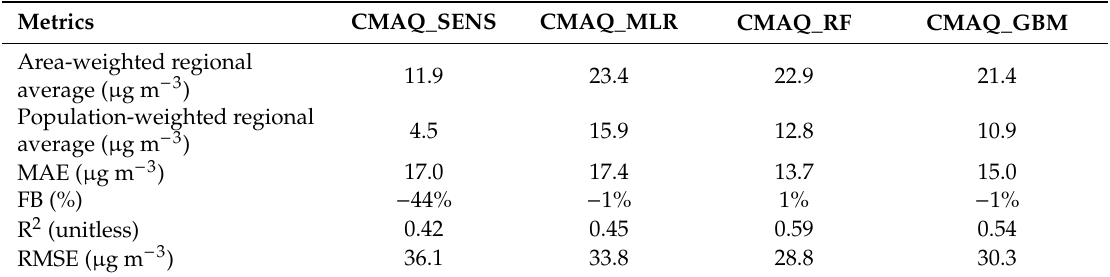
Table 4. The modeling performance before and after data integration based on 10-fold CV. Metrics